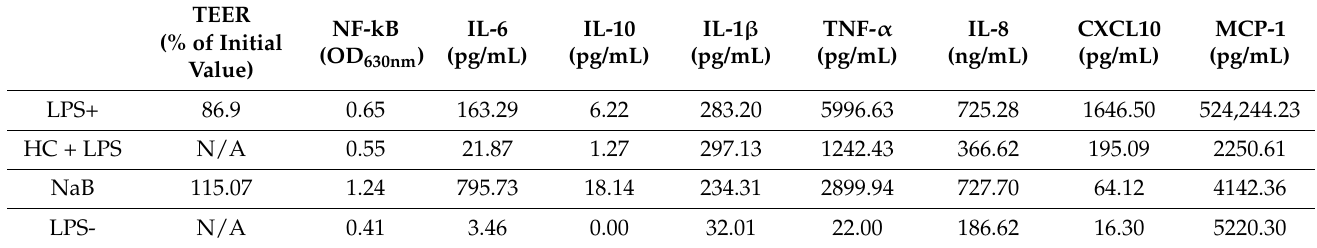
Table 2. Quality control measurements for the leaky gut cell culture model (Caco-2/THP-1). LPS positive control was stimulated with LPS, but no protein was